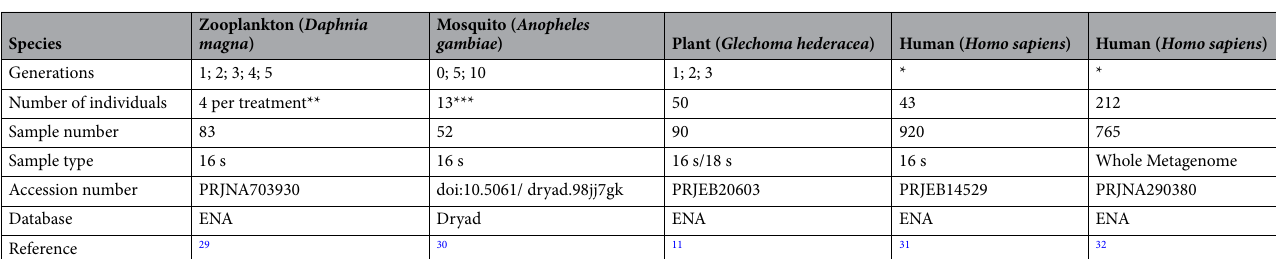
Table 1. Datasets included in this study. *All the samples belong to a single generation, ** 5 individuals were pooled, *** Number of treatment replicates instead of